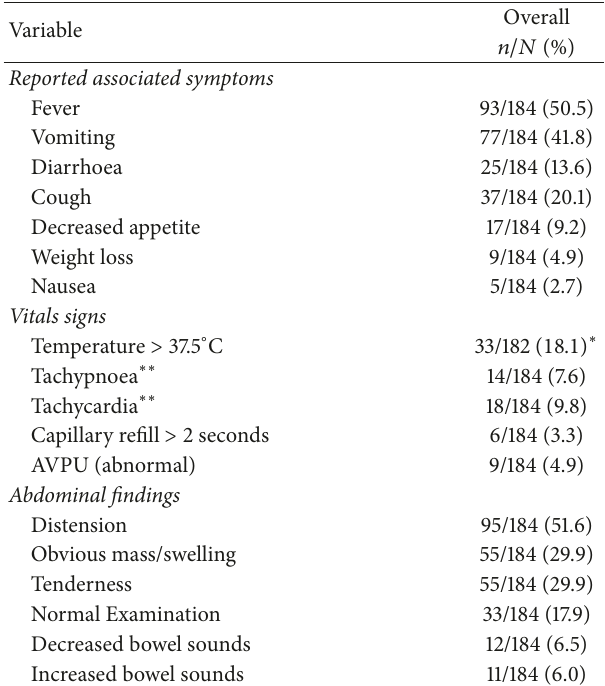
Table 2: Reported associated complaints, vital signs, and physical